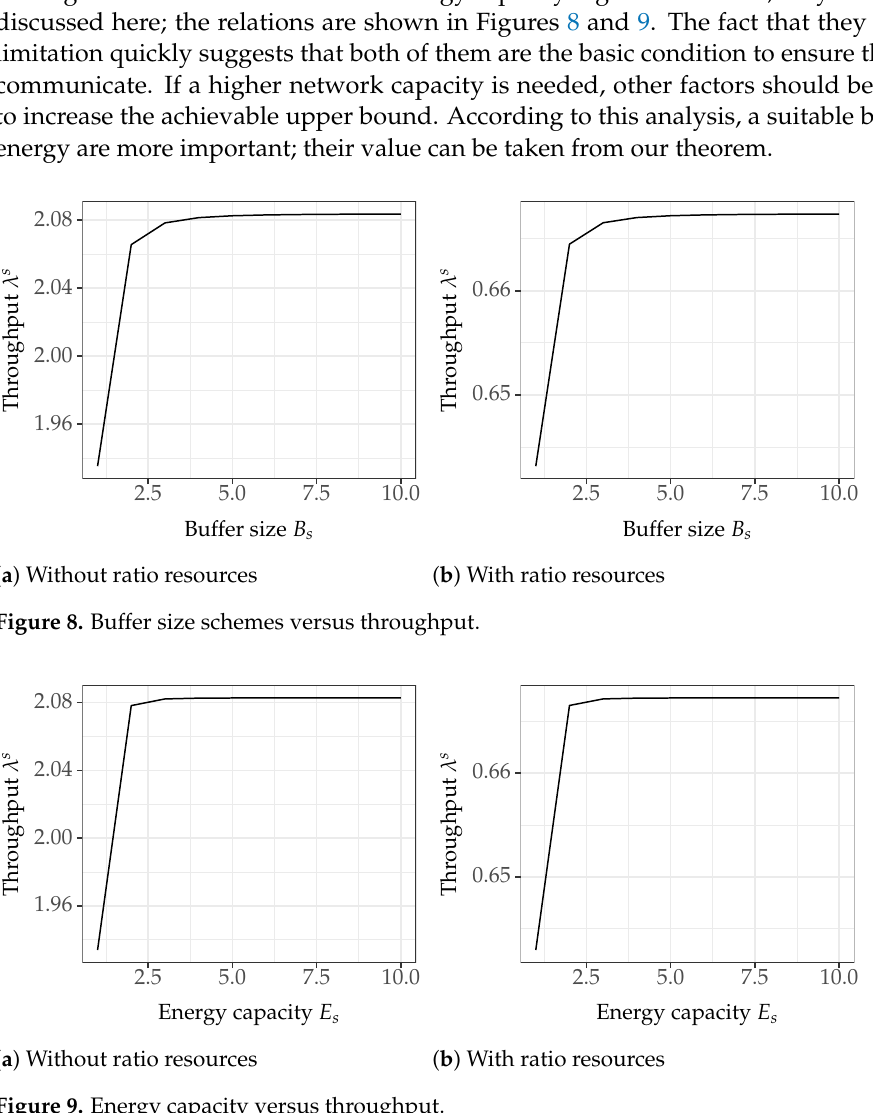
Figure 9. Energy capacity versus